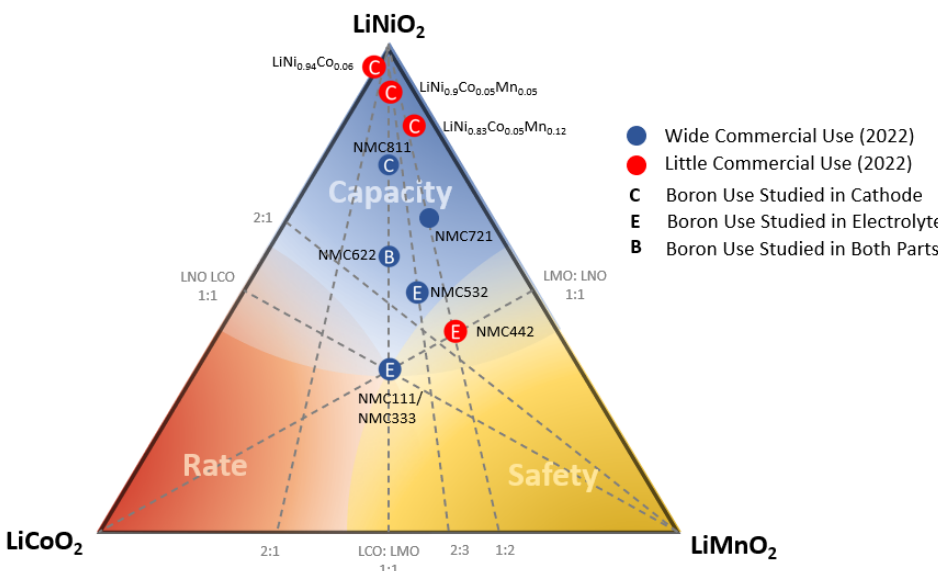
Figure 5. Ternary plot of NMC systems.